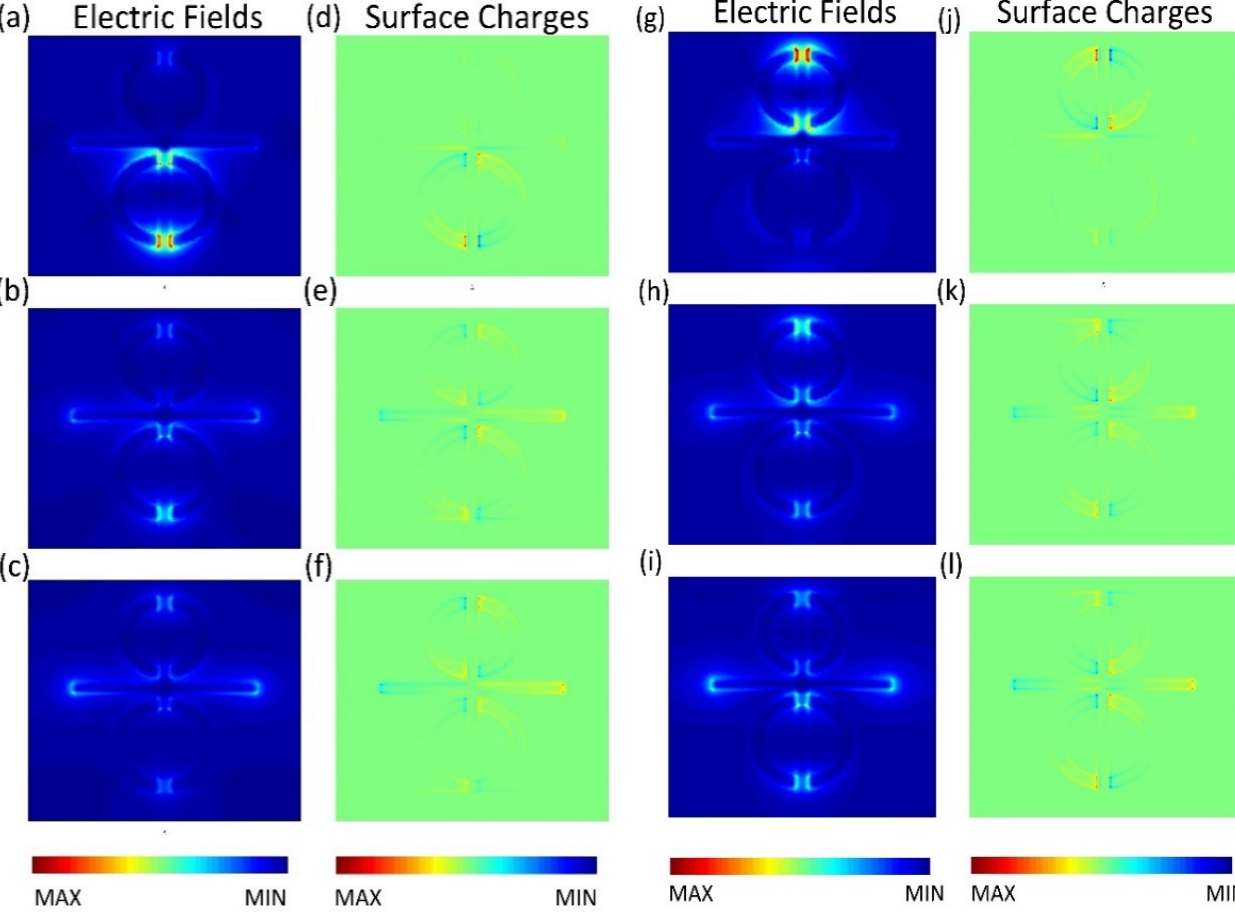
Figure 7. The distribution of ( a – c ) electric field and ( d – f ) surface charge at the PIT resonance with different strip 2 Fermi levels of No Gra, 0.4 eV and 1.2 eV. The distribution of ( g – i ) electric field and ( j – l ) surface charge at the PIT resonance with different strip 1 Fermi level of No Gra, 0.4 eV and 1.2 eV.